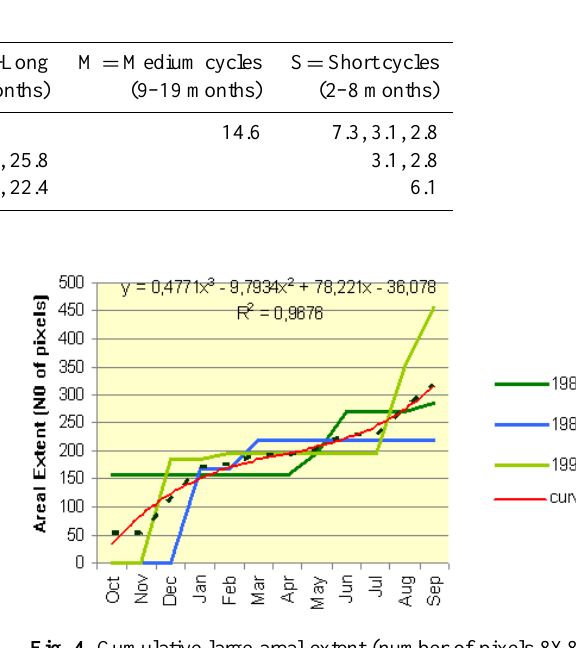
Table 4. Drought periodicities using the Z -index.